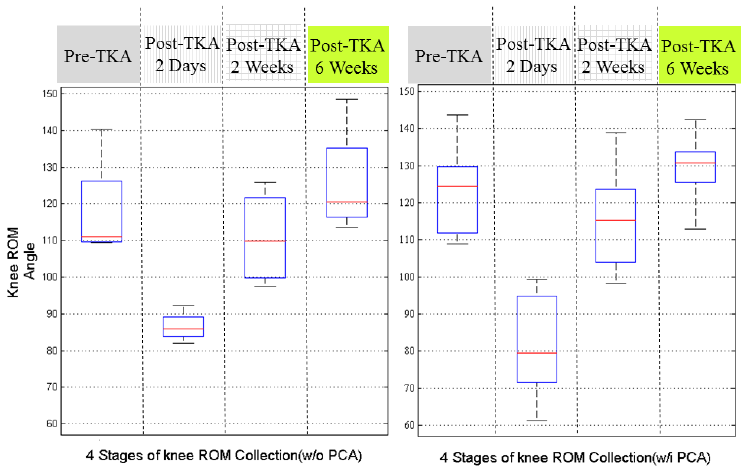
Figure 7. The recovery knee ROM between patients with and without Epidural PCA (EPCA).